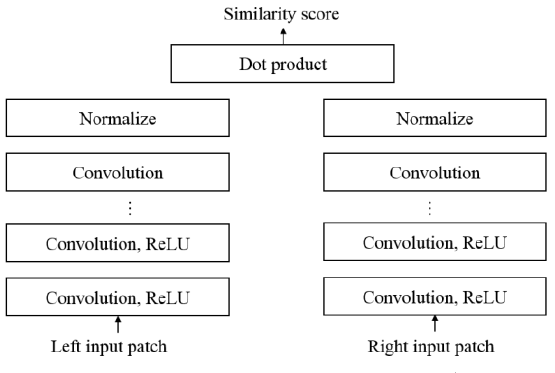
Figure 1. Learning similarity score by MC-CNN (cited from (Žbontar and Lecun, 2014))